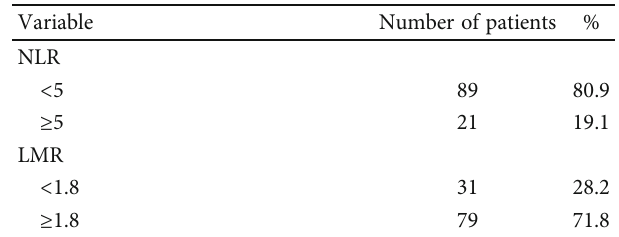
Table 1: Patient characteristic. Table 1: